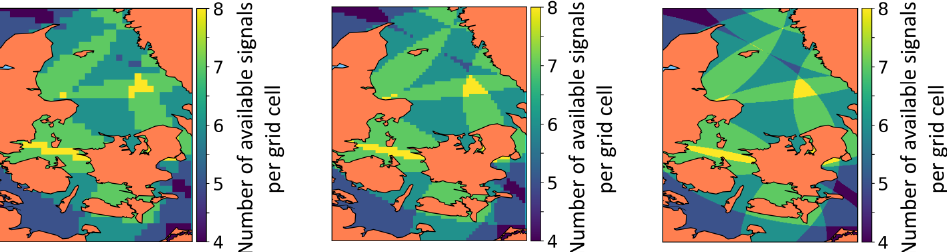
Figure 1. Comparison of different grid-cell resolutions for the number of available radio beacon signals (left to right): 0.10°, 0.05° and 0.01°.